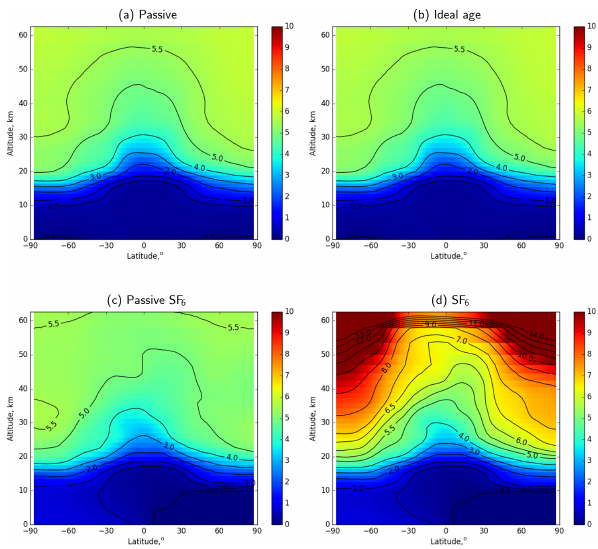
Figure 11. Zonal-mean distributions of atmospheric AoA simulated with passive , ideal-age , and two SF 6 tracers (average for 2012).